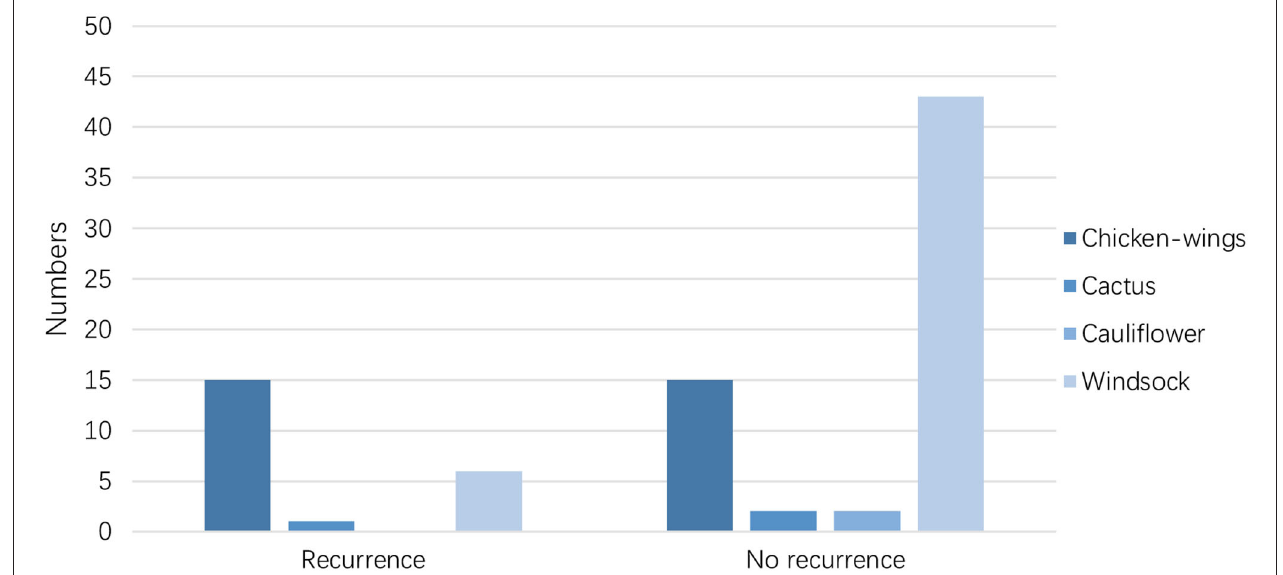
FIGURE 2 | LAA morphology with AF